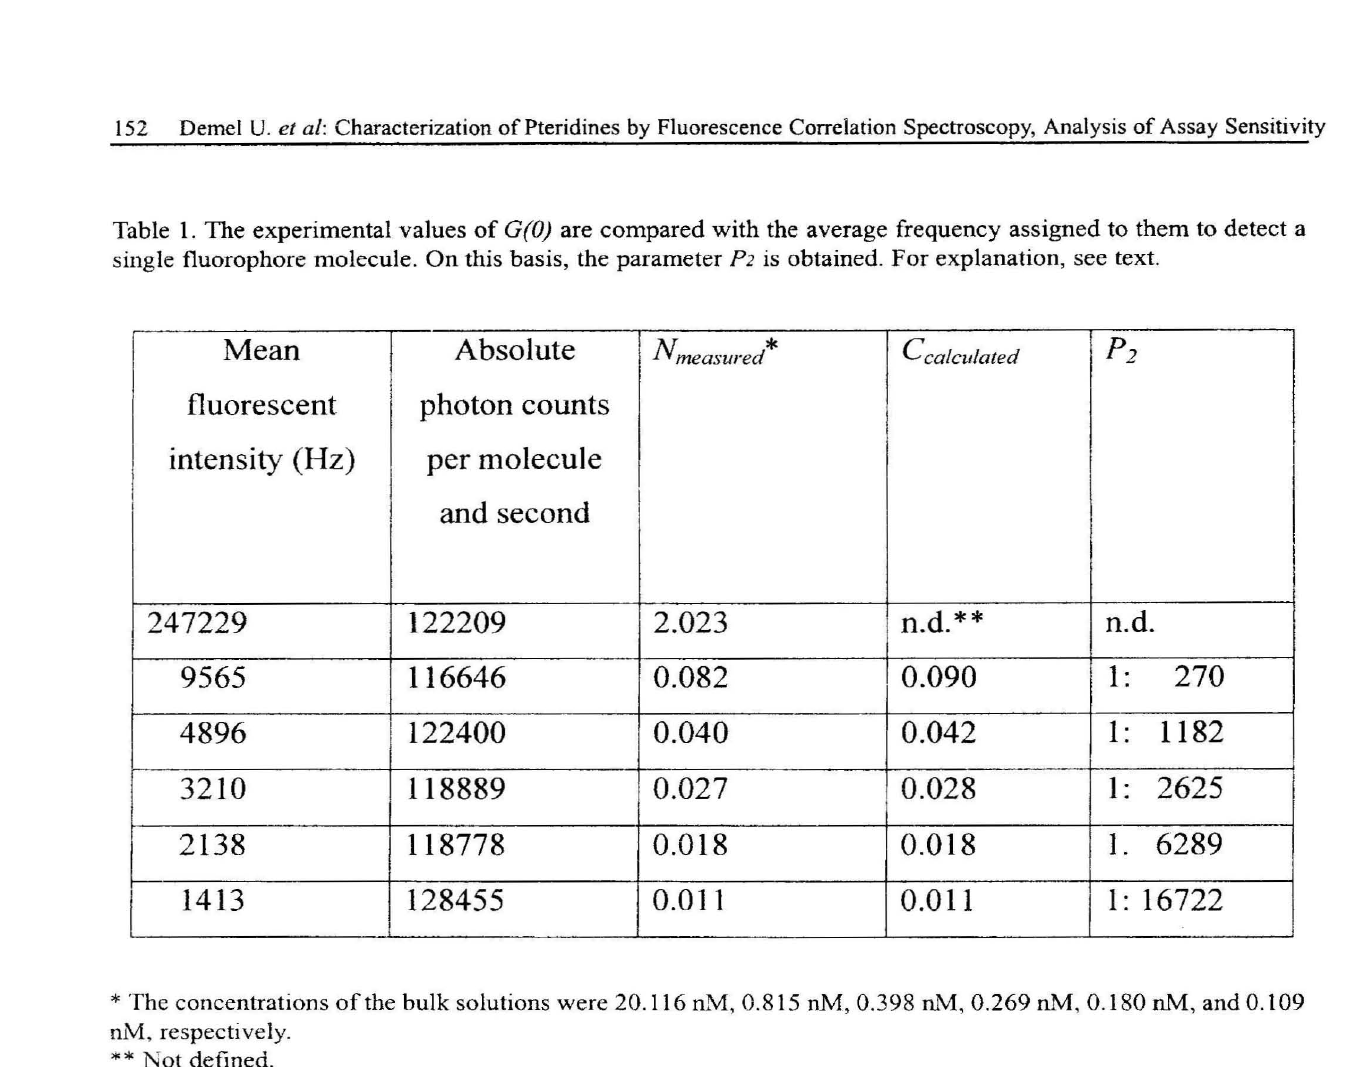
Table 1. The experimental values of G(O) are compared with the average frequency assigned to them to detect a single fluorophore molecule. On this basis, the parameter P2 is obtained. For explanation, see